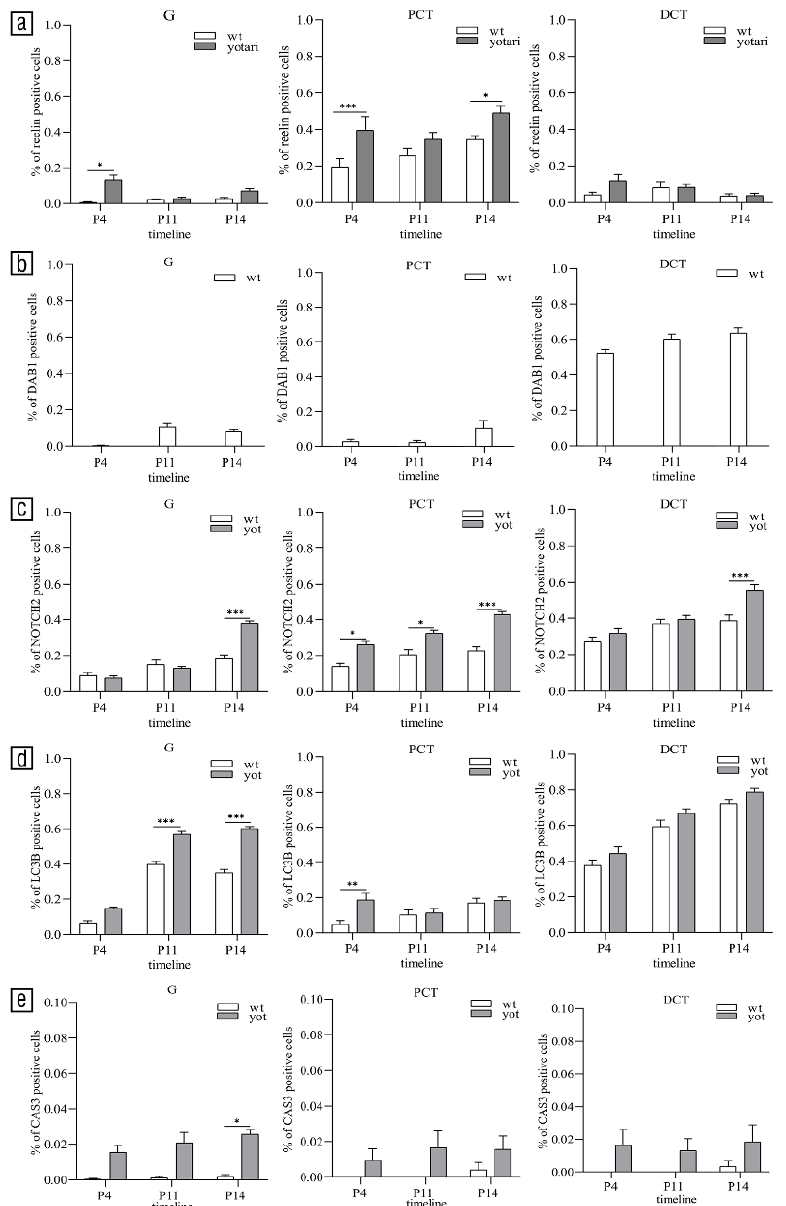
Figure 3. The distribution of the percentages of reelin ( a ), DAB1 ( b ), NOTCH2 ( c ), LC3B ( d ) and cleaved CASP3-positive ( e ) cells in the glomeruli (G), proximal convoluted tubules (PCT), distal convoluted tubules (DCT) of wild-type and yotari kidneys. Data presented as the mean ± SEM (vertical line). Significant differences were indicated by * p < 0.05, ** p < 0.001, *** p < 0.0001 (Two-way ANOVA followed by Tukey’s multiple comparison test). At each time point, 20 PCTs, DCTs, and glomeruli were assessed.